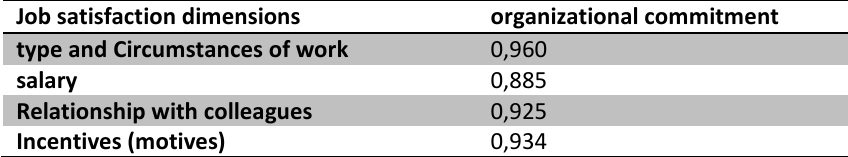
Table 5. Results Pearson correlation coefficient between Job satisfaction dimensions and organizational